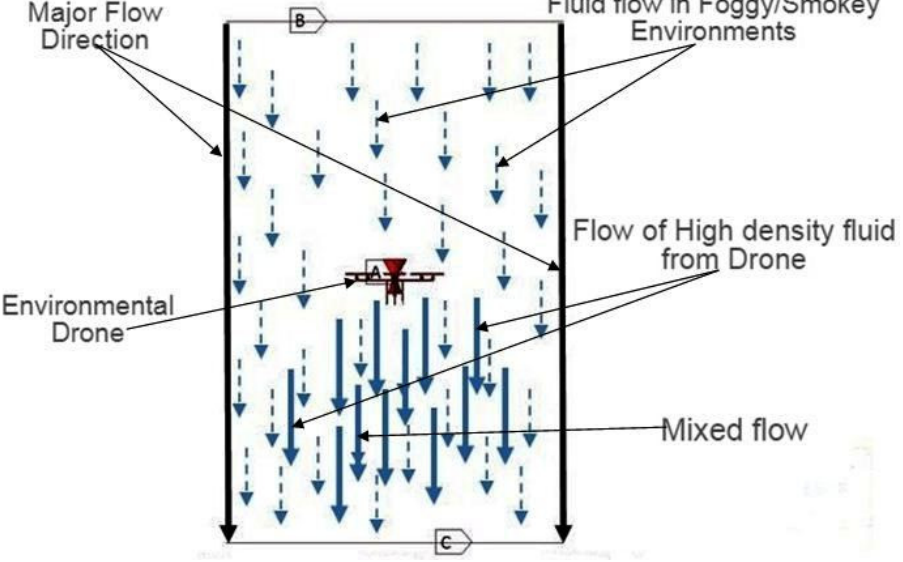
Figure 2. Concept involved in this study.